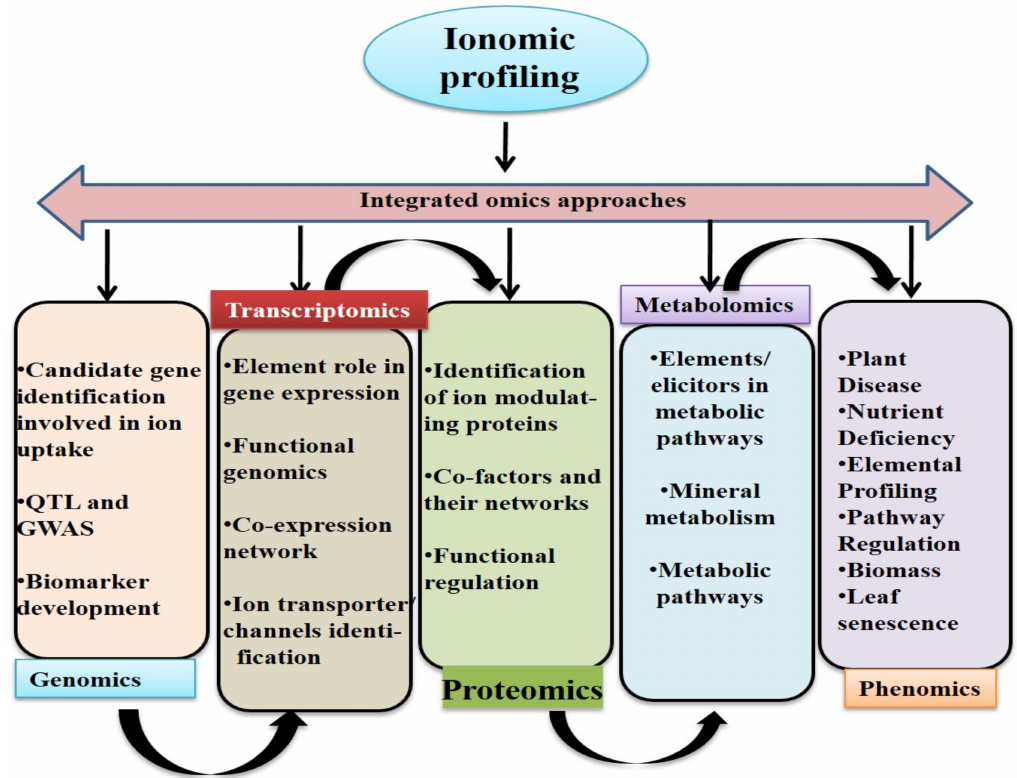
Figure 4. Ionomics and its integration with other omics approaches for identifying stress-resilient genes. Integration of multi-omics approaches provides the overall picture of the information flow from the upstream step of central dogma (genomics) to the last downstream level (metabolomics) that can define the phenotype. All omics are interdependent; hence, their integration will possibly allow the identification of potential genes and their regulatory networks, which can be used for developing smart crops for sustainable agriculture via genome editing or molecular